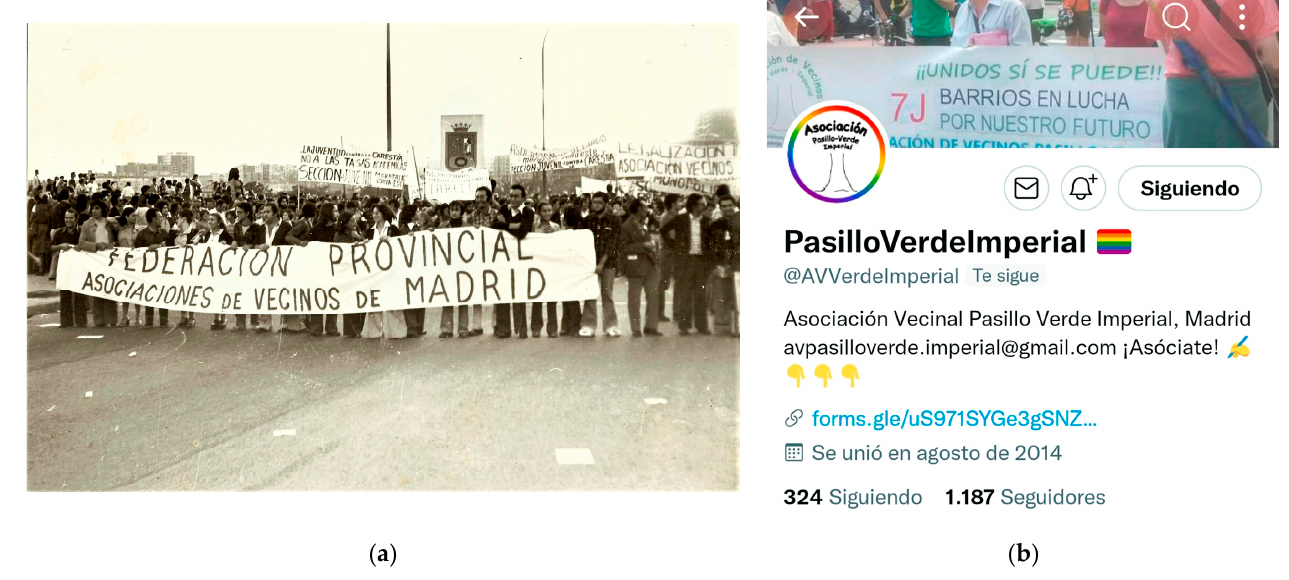
Figure 4. Activism of neighborhood associations of Madrid after the Democratic Transition. ( a ) First protest of the neighborhood associations of Madrid in 1977 (Archivos de la Transición [18]); ( b ) an example of the presence of neighborhood associations on social networks: the current profile of the Pasillo Verde Imperial Association on Twitter.